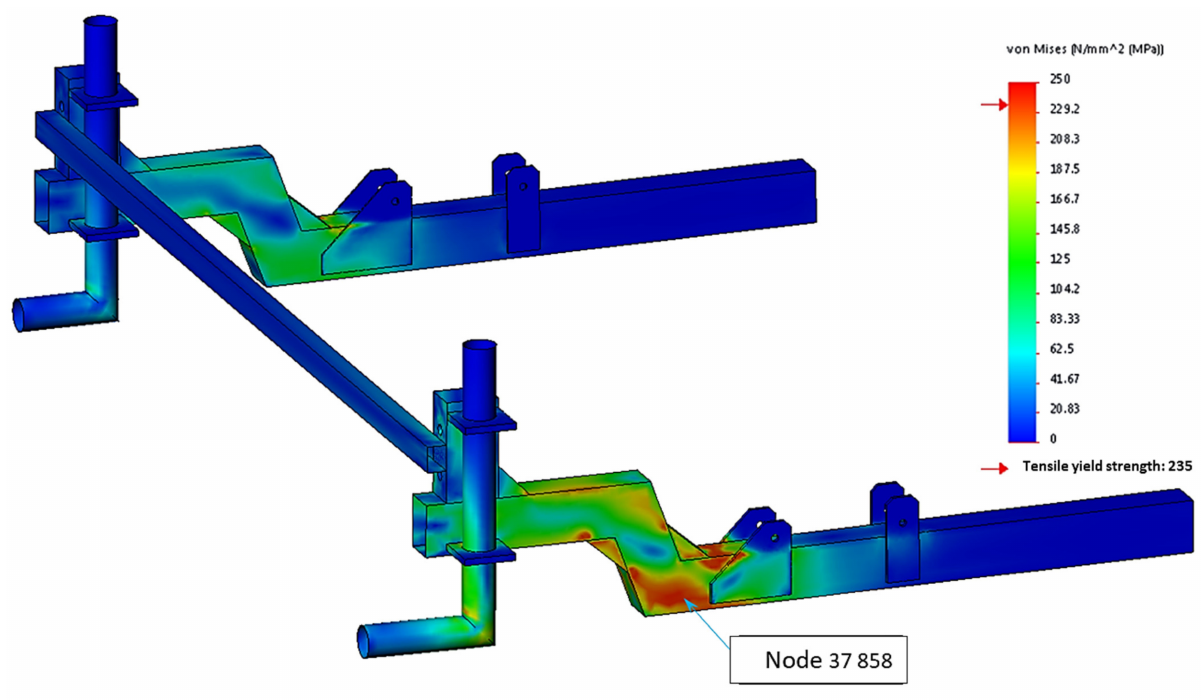
Figure 12. Von Mises’s stress distribution in the optimized ASC